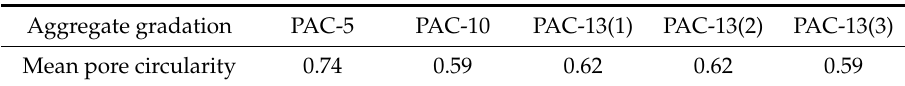
Figure 8. ( a ) Pore circularity distributions along the specimen height direction. ( b ) Percentage of pore number in the range of pore circularity. Table 4. Mean pore